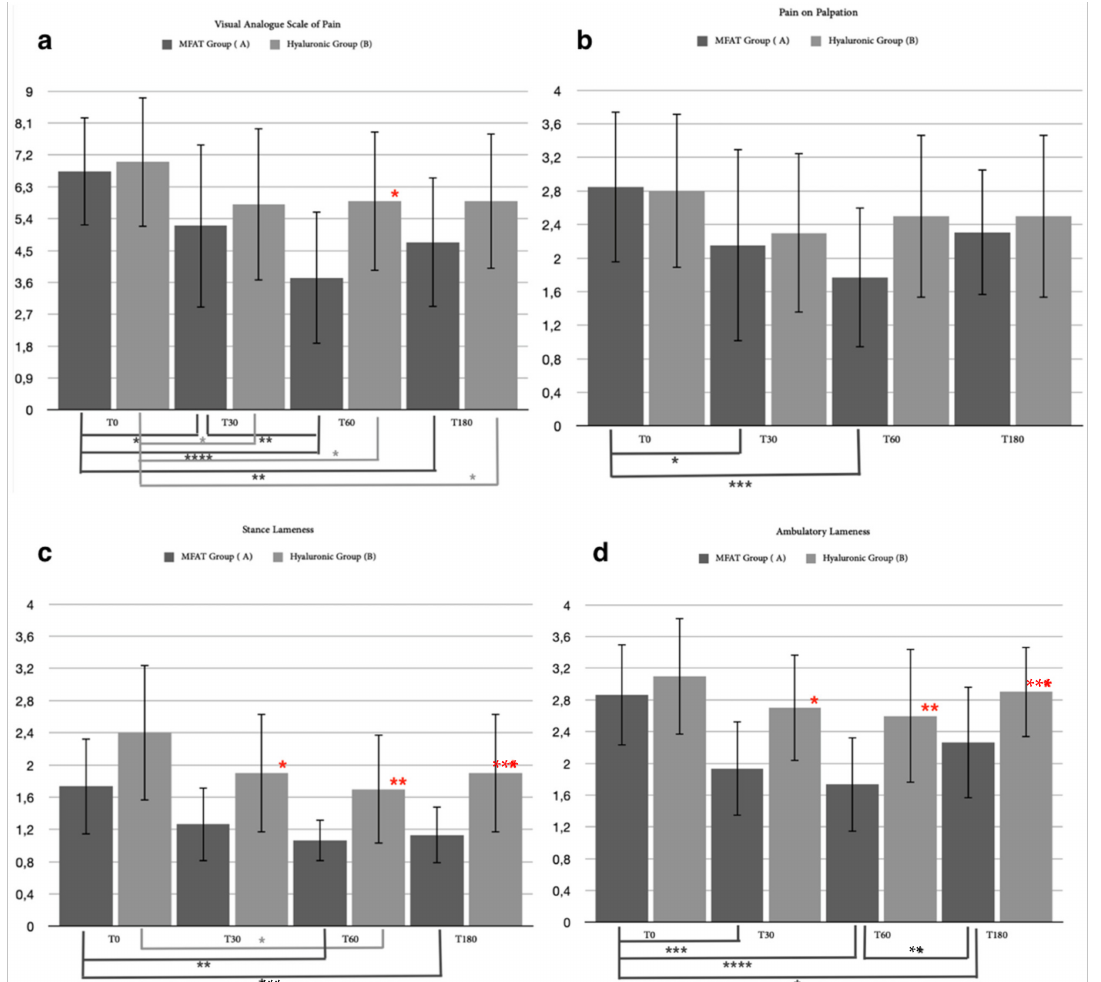
Figure 11. Differences in statistical analysis data between hyaluronic group and MFAT group for ( a ) visual analogue score of pain after 30 days, 60 days, and 180 days. Red asterisks (*: p = 0.01) indicate significant differences between groups, and group-colored asterisks indicate significant differences within each group (*: p < 0.05; **: p < 0.01; ****: p < 0.0001); ( b ) pain on palpation after 30 days, 60 days, and 180 days. Group-colored asterisks indicate significant differences within each group (*: p = 0.0109; ***: p = 0.0002); ( c ) stance lameness after 30 days, 60 days, and 180 days. Red asterisks (*: p = 0.0259; **: p = 0.0059; ***: p = 0.0064) indicate significant differences between groups, and group-colored asterisks indicate significant differences within each group (*: p = 0.0464; **: p = 0.0089; ***: p = 0.0196); and ( d ) ambulatory lameness after 30 days, 60 days, and 180 days. Red asterisks (*: p = 0.0118; **: p = 0.0094; ***: p = 0.0413) indicate significant differences between groups, and group-colored asterisks indicate significant differences within each group (*: p = 0.0339; **: p = 0.0477; ***: p = 0.0007; ****: p <